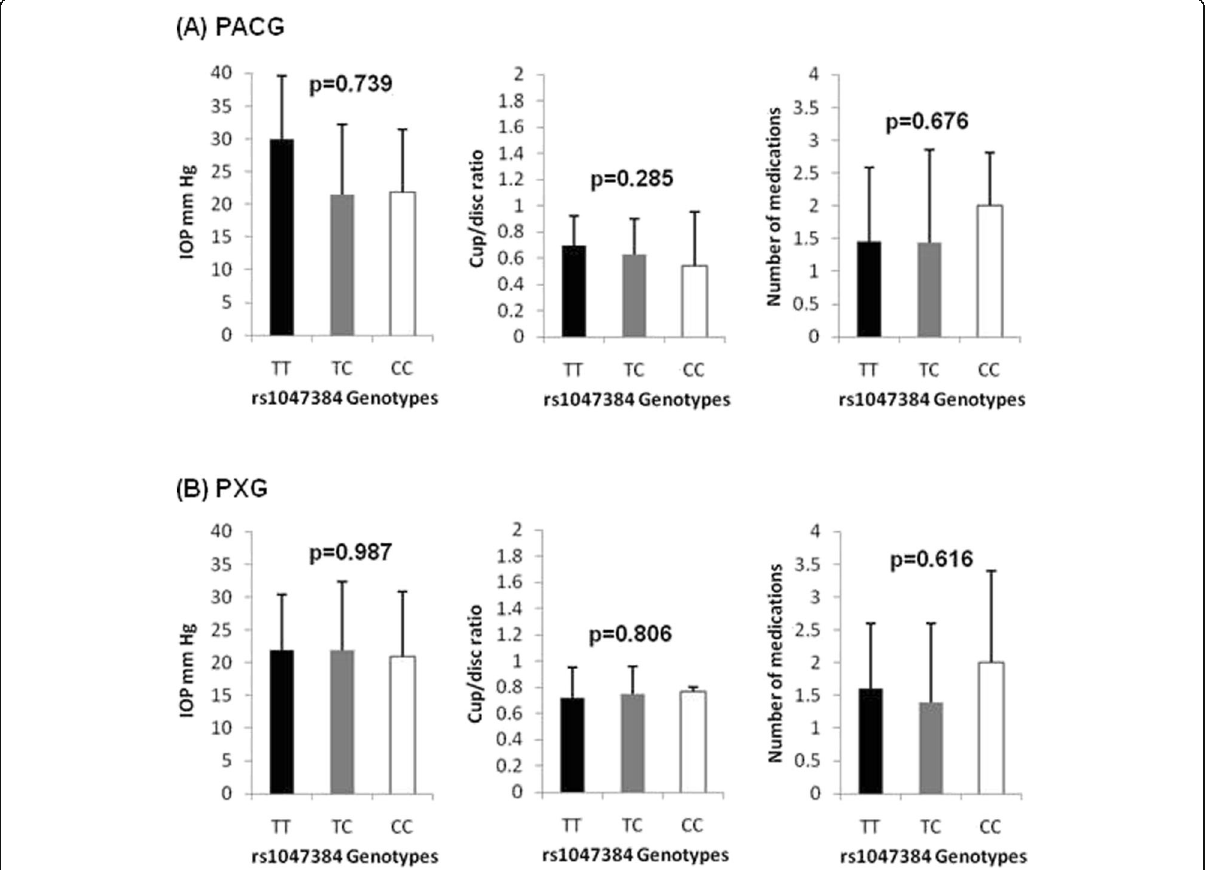
Fig. 3 Genotype effects of rs1043784 variant on intraocular pressure (IOP), cup/disc ratio and number of antiglaucoma medication in ( a ) PACG and ( b ) PXG patient